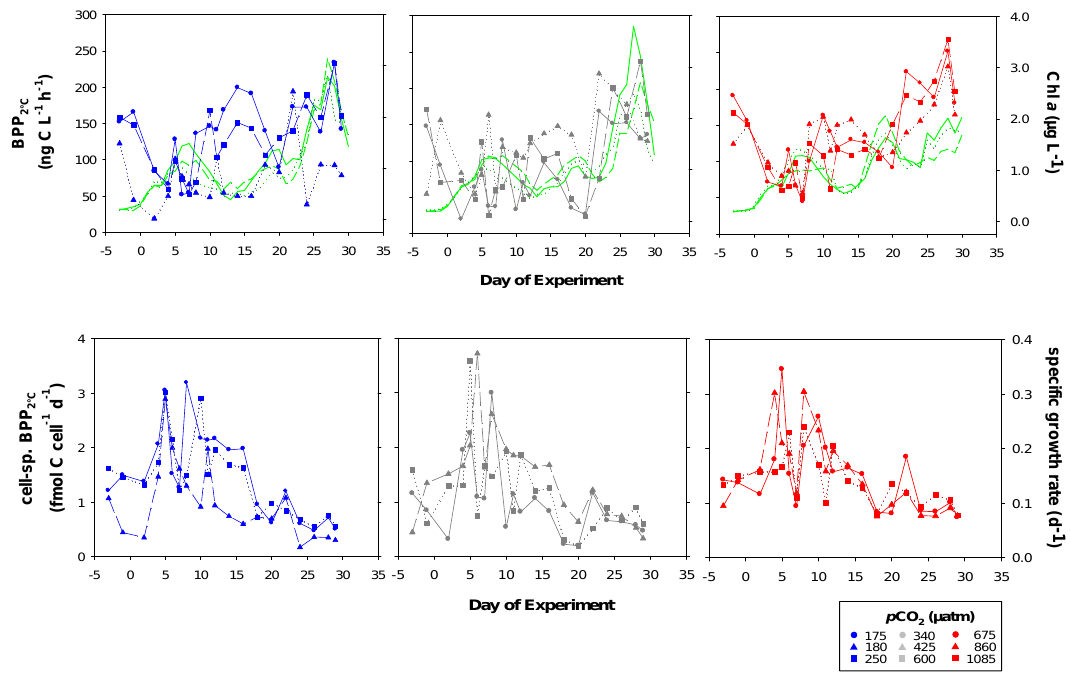
Fig. 3. Temporal development of bacterial protein production (BPP 2 ◦ C ) and specific growth rates (d − 1 ) at 2 ◦ C in mesocosms of low (175– 250µatm; blue symbols), medium (340–600µatm; grey symbols) and high p CO 2 (675–1085µatm; red symbols). Upper panel: BPP 2 ◦ C normalised to volume (ngCL − 1 h − 1 ) , green lines represent chlorophyll a concentrations (Chl a , µgL − 1 ) . Lower panel: BPP 2 ◦ C normalised to bacterial abundance (cell-specific BPP 2 ◦ C , fmolCcell − 1 d − 1 ) and corresponding specific growth rate (d − 1